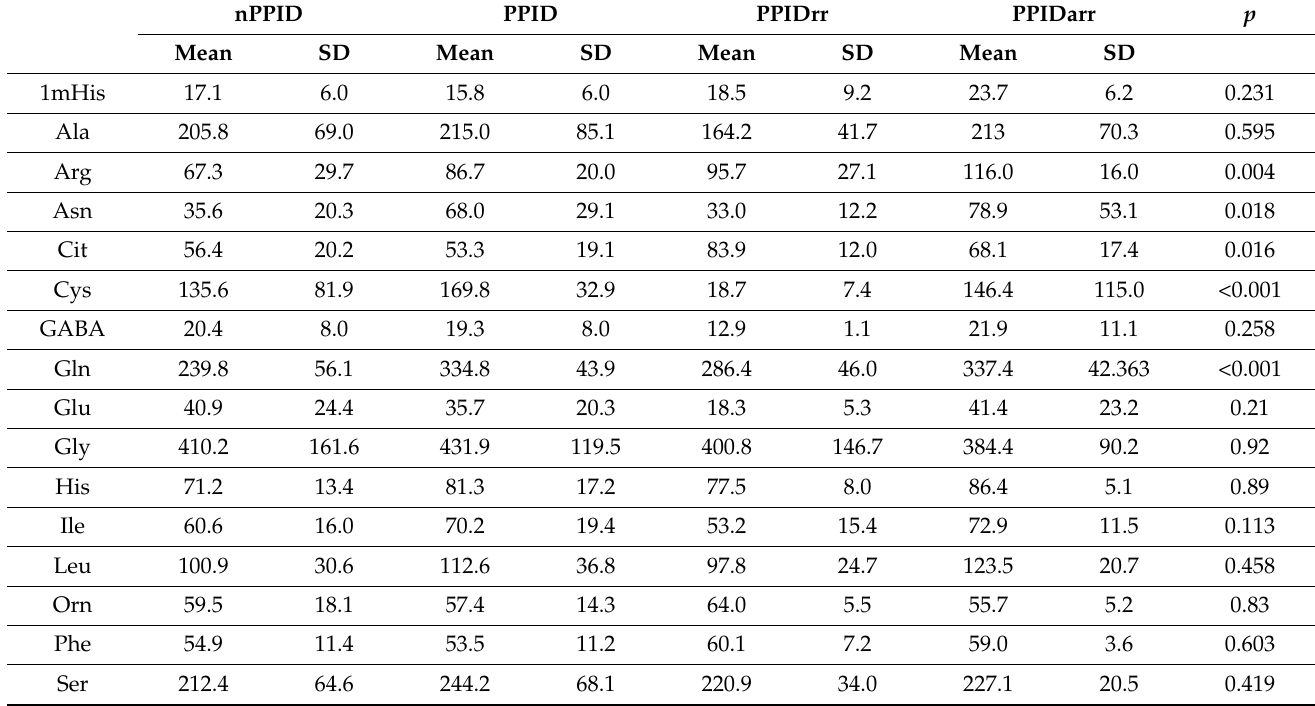
Table 2. Mean and standard deviations of the normally distributed amino acid concentrations (nmol/mL); p -values